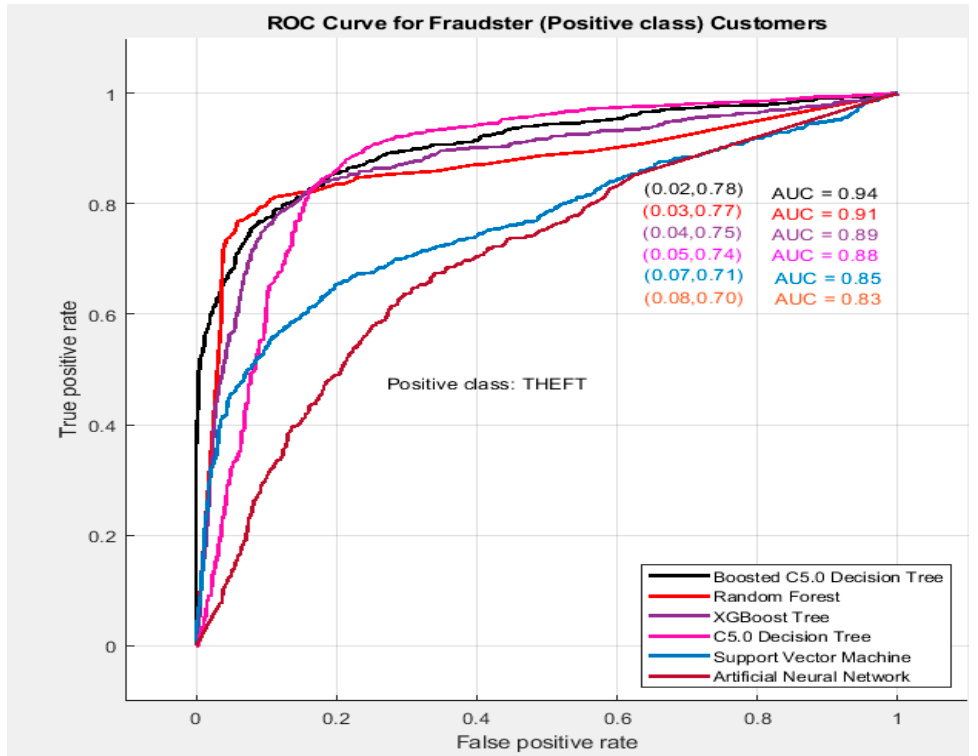
Figure 5. ROC Curve for fraudster (positive class) customers.